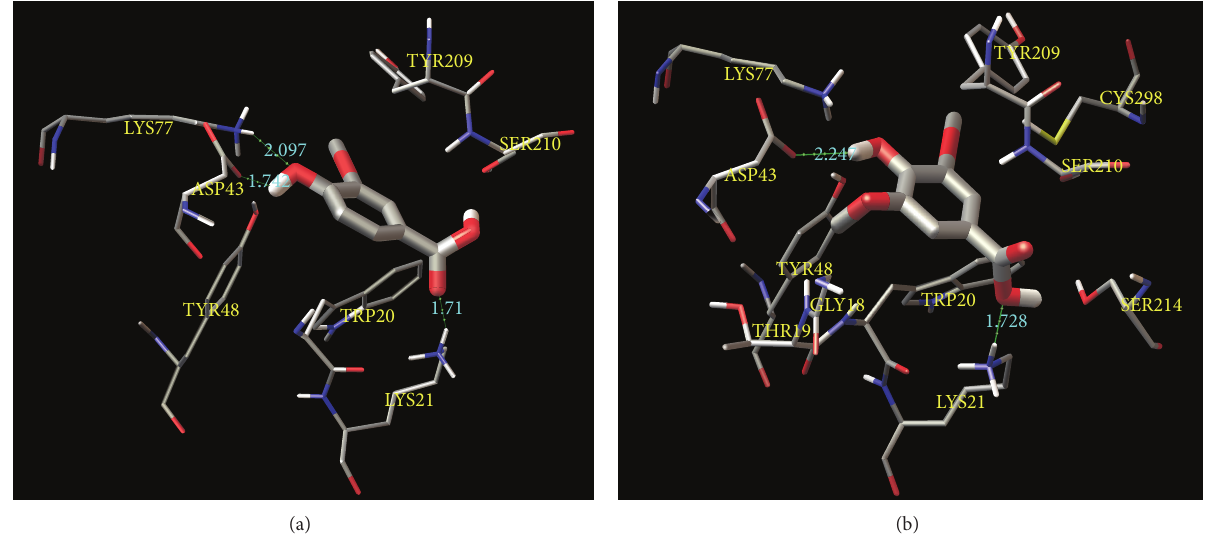
Figure 5: Interaction analysis of methoxybenzoic acid derivatives docked with ALR2. Binding pose of vanillic acid (a) and syringic acid (b). The amino acid residues (in 1 ˚A distance) were represented in atom types and the hydrogen bonds were denoted in green spheres along with the distance.